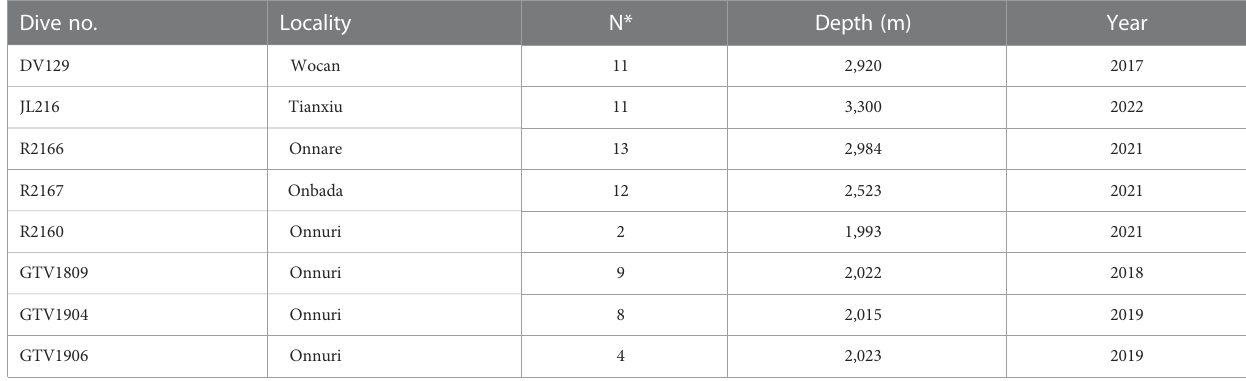
TABLE 2 Sampling